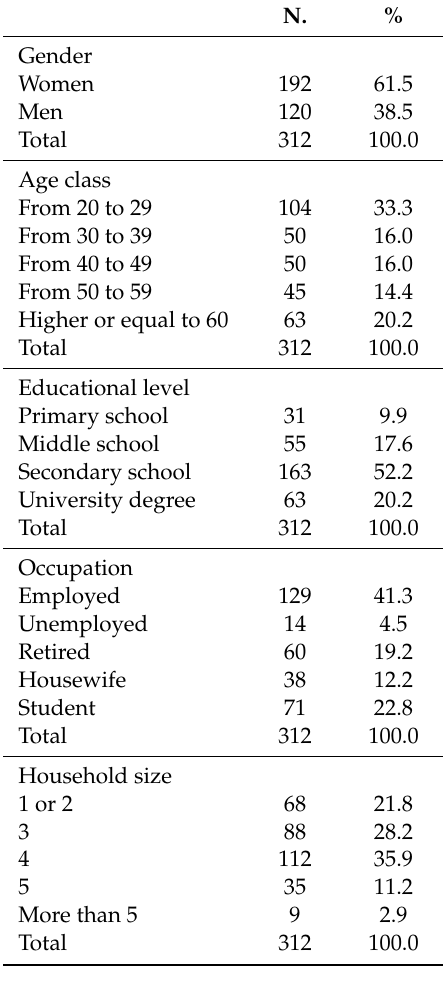
Table 2. Socioeconomic characteristics of the interviewees.